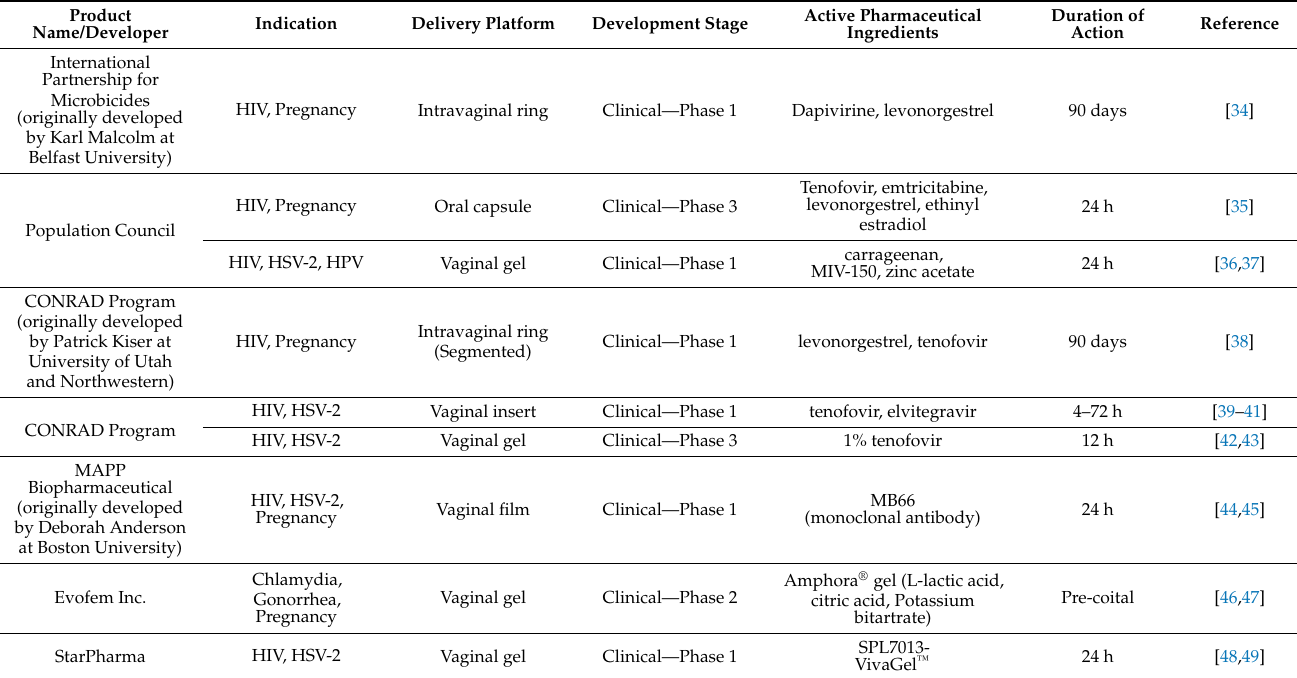
Table 1. MPTs in clinical